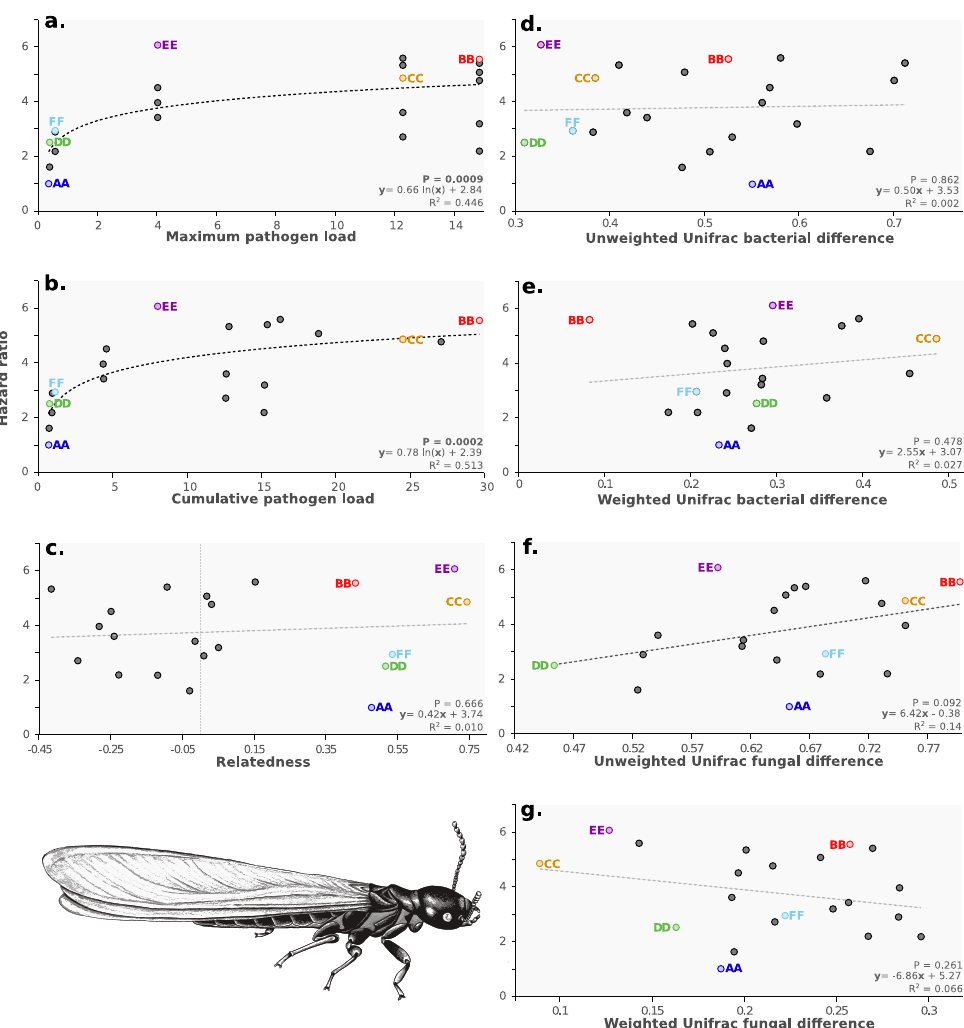
Fig. 3 Factors in fl uencing pairing survival. Correlation between hazard ratio of a pairing and the maximum pathogen load ( a ), cumulative pathogen load ( b ), relatedness ( c ), unweighted Unifrac bacterial difference ( d ), weighted Unifrac bacterial difference ( e ), unweighted Unifrac fungal difference ( f ) and weighted Unifrac fungal difference ( g ). Trendlines represent logarithmic correlations for plots a , b , and denote linear correlations for all the other plots. In each plot, inbred pairings are colored according to their colony of